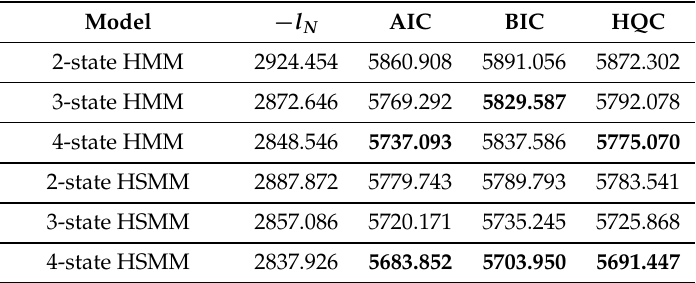
Figure 1. Daily closing prices (top) and log returns (bottom) of Bitcoin/US dollar (BTC/USD) from 1 January 2016 to 28 January 2019. Table 1. Goodness-of-fit statistics of stationary normal HMMs and homogeneous normal HSMMs with negative binomial dwell-time distributions for 2, 3, and 4 states based on the entire series of daily log returns of BTC/USD. Table reproduced from